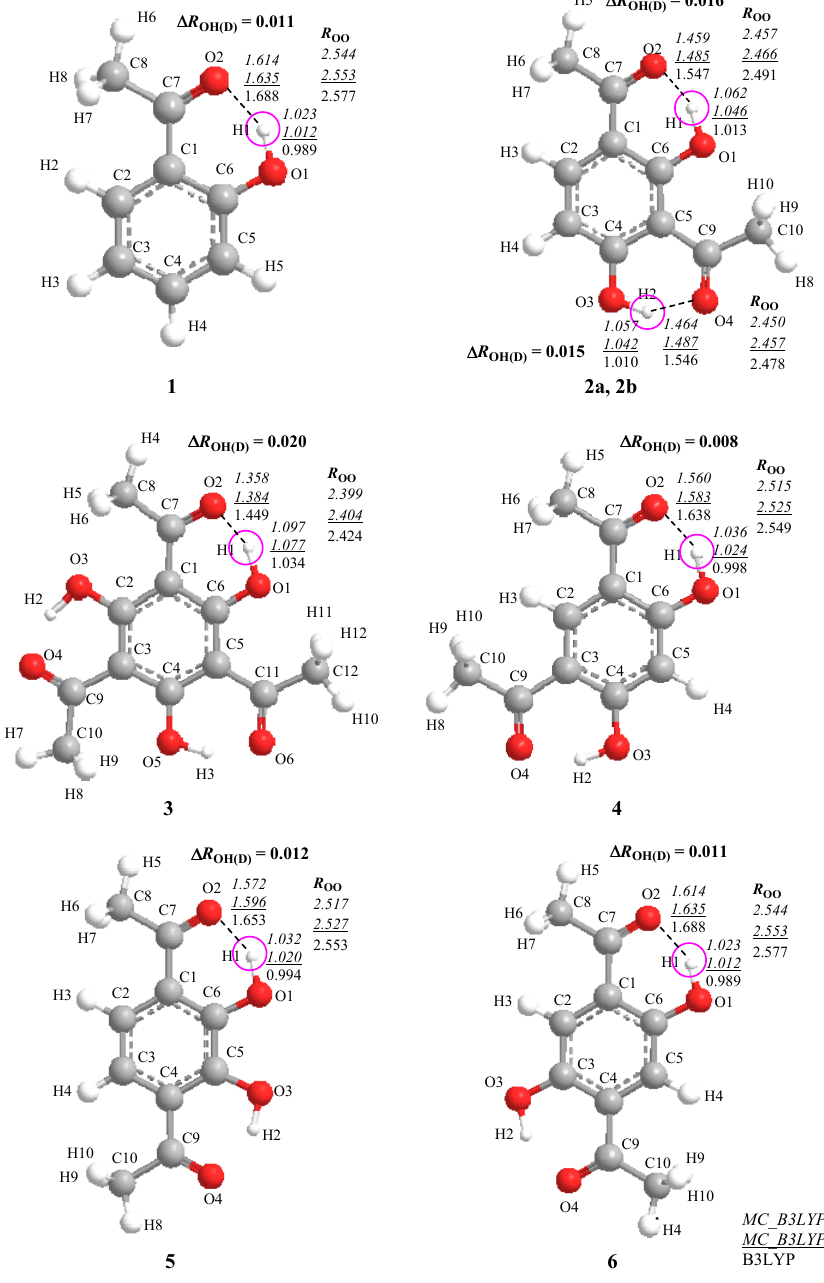
Figure 1. Optimized structures and geometrical parameters (Å) of intramolecular hydrogen-bonded